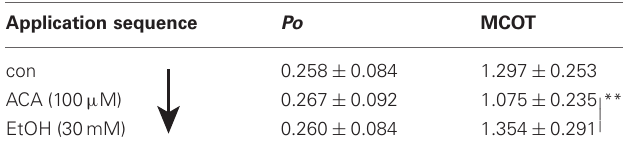
Table 4 | Sequence ( ↓ ) of application from top to bottom: